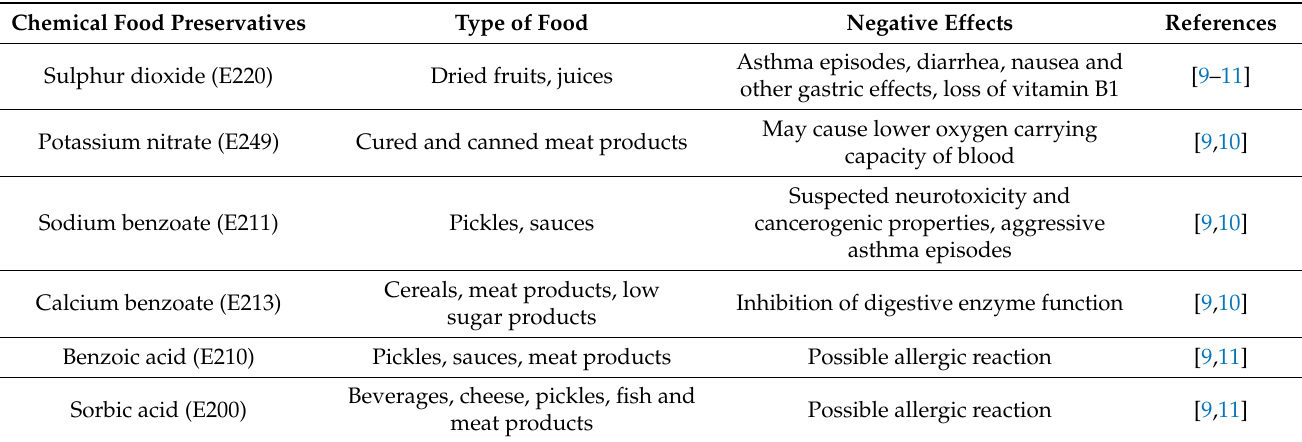
Table 1. The most used chemical preservatives and examples of their negative health impact. Chemical Food Preservatives Type of